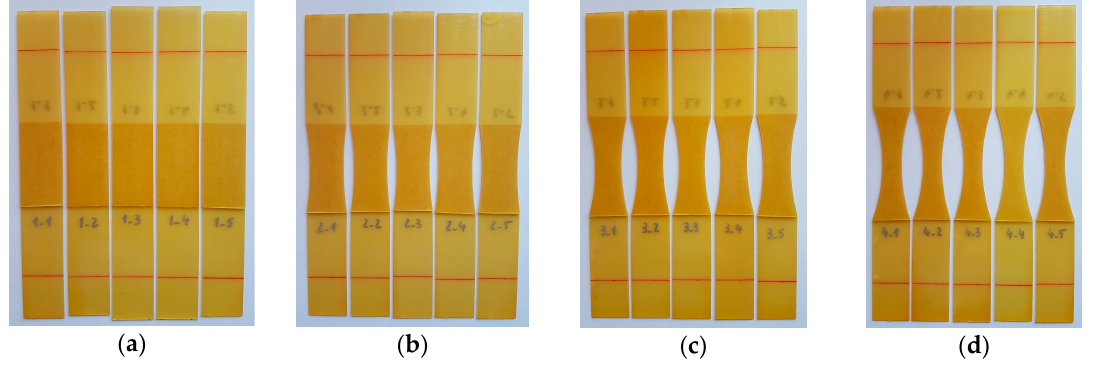
Figure 9. Samples before testing: ( a ) Model 1, ( b ) Model 11, ( c ) Model 12, ( d ) Model 13.